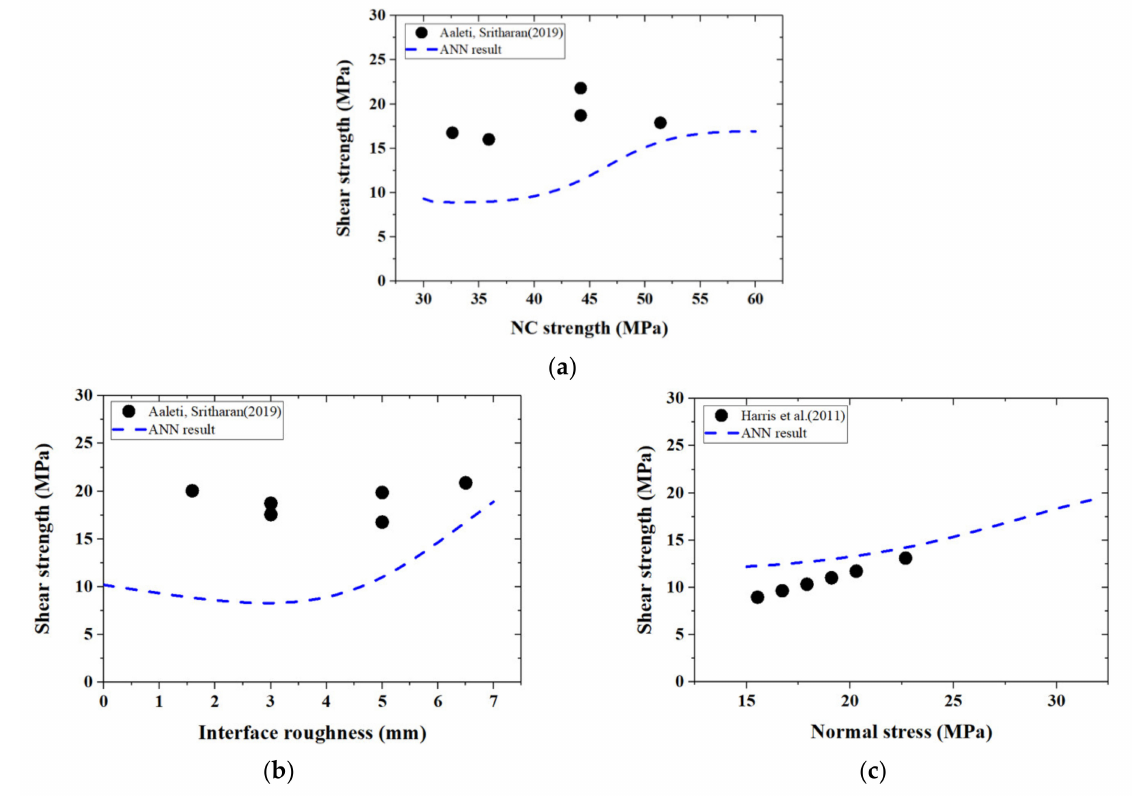
Figure 10. Influence of factors on shear strength. ( a ) Effect of f NC ; ( b ) effect of R ; ( c ) effect of σ